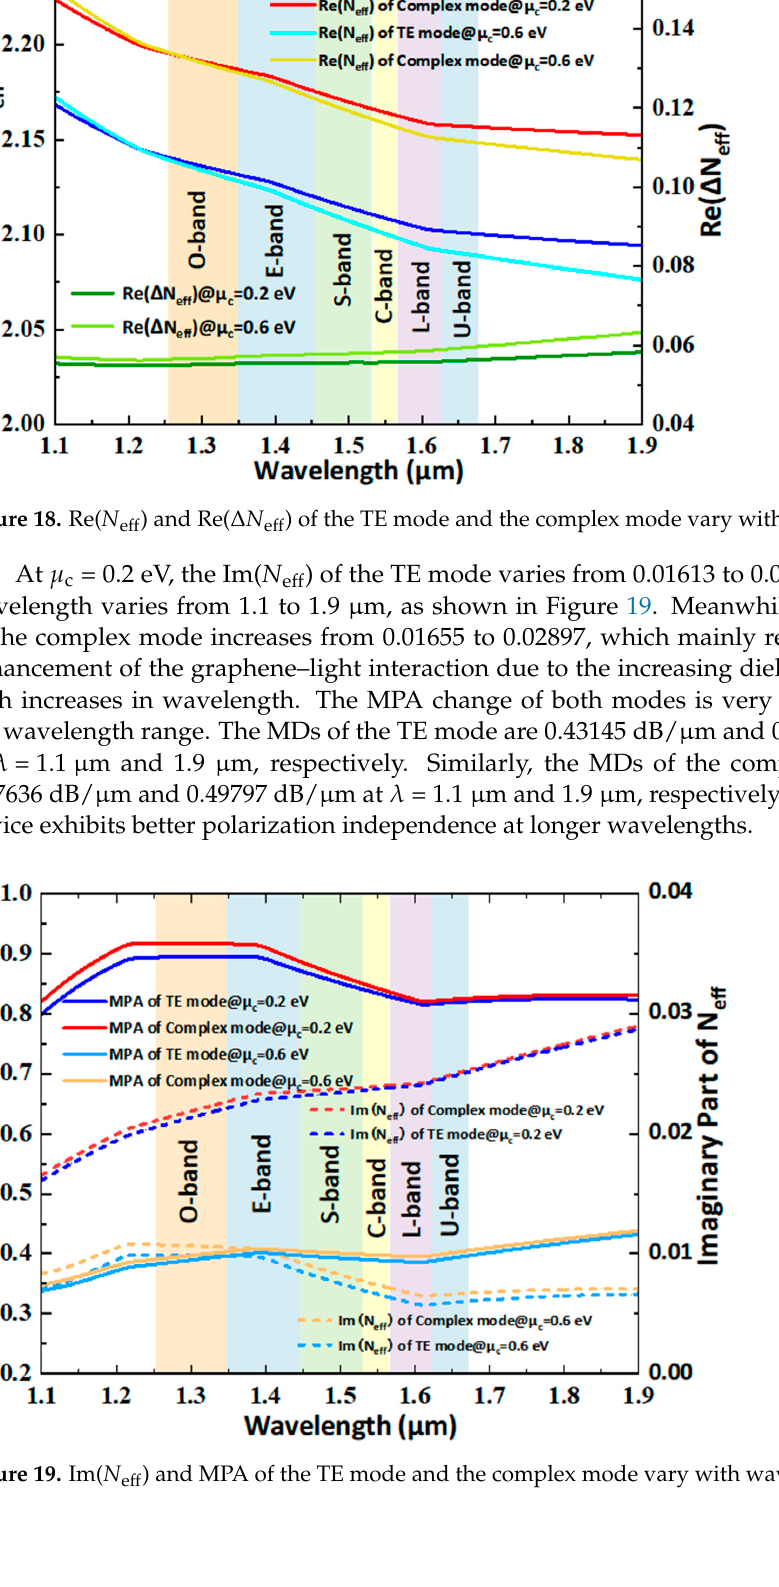
Figure 19. Im( N eff ) and MPA of the TE mode and the complex mode vary with